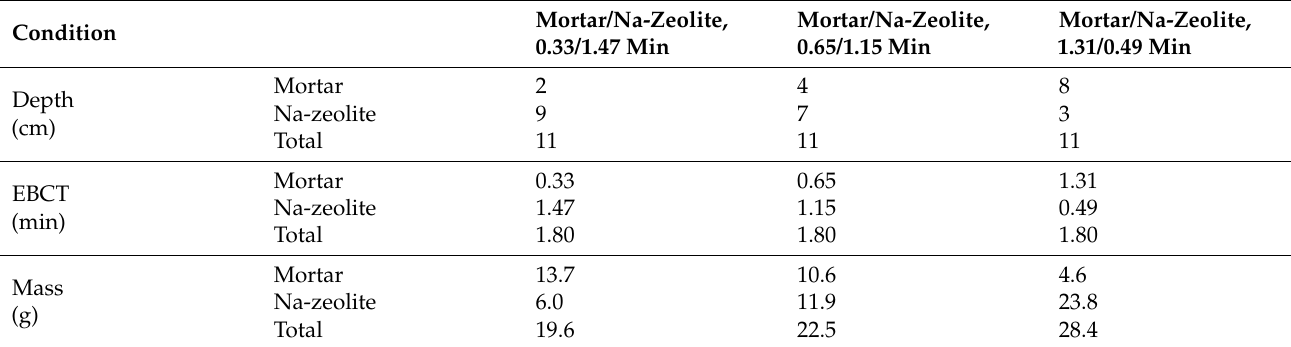
Table 3. Mixed heavy metal removal test conditions with mortar/Na-zeolite dual media according to the ratio of